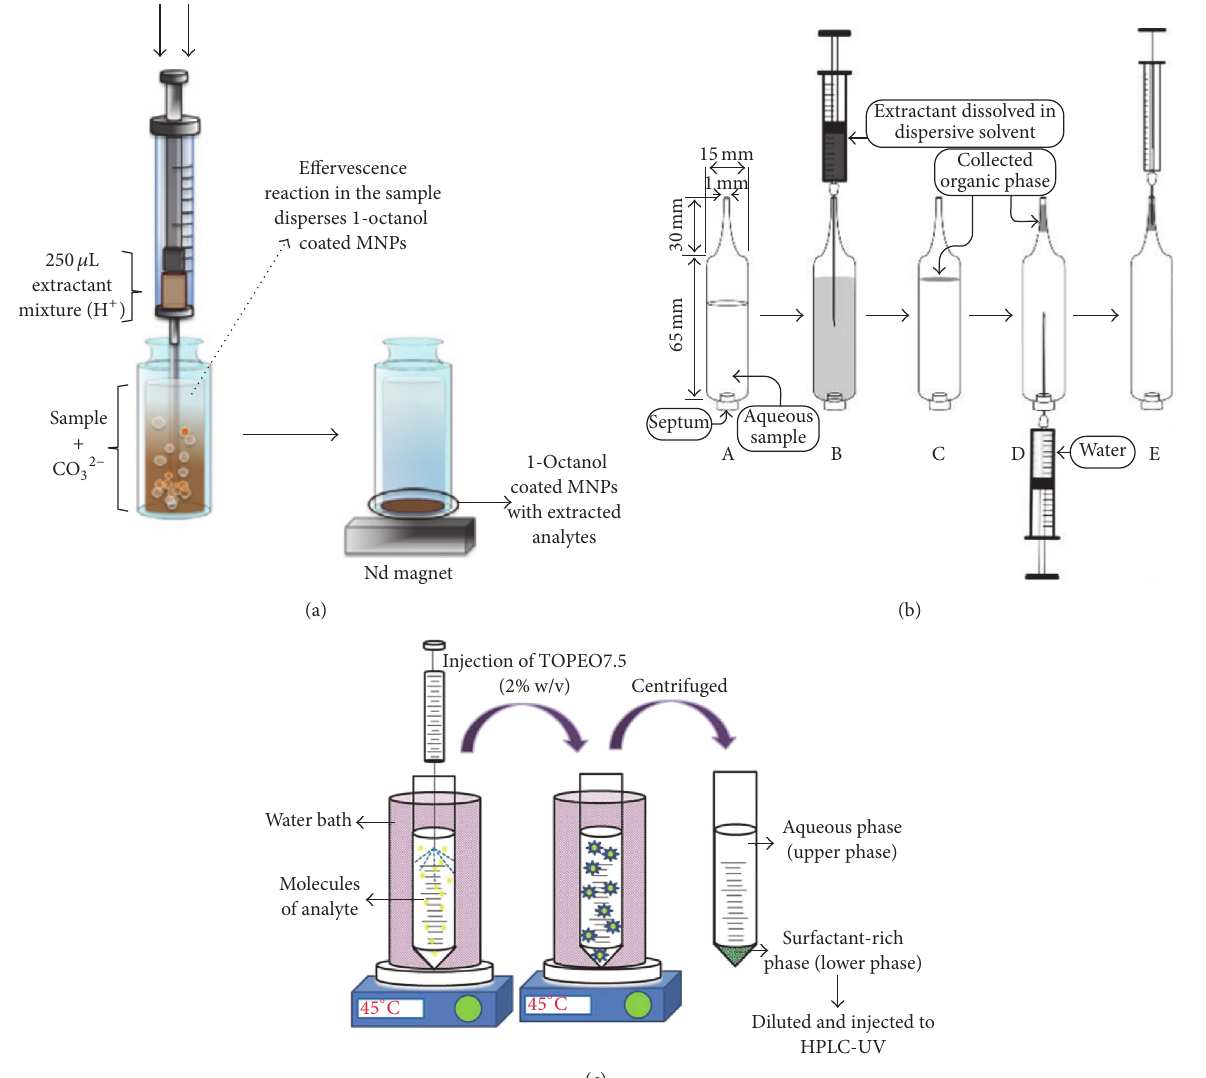
Figure 2: Schematic diagram of (a) effervescence DLLME [46], (b) LDS-DLLME using specialist glassware [52], and (c) CP-DLLME [48].